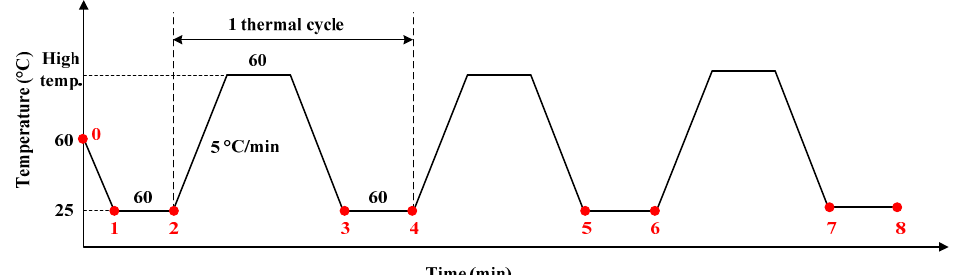
Figure 7. Loading history for the analysis.